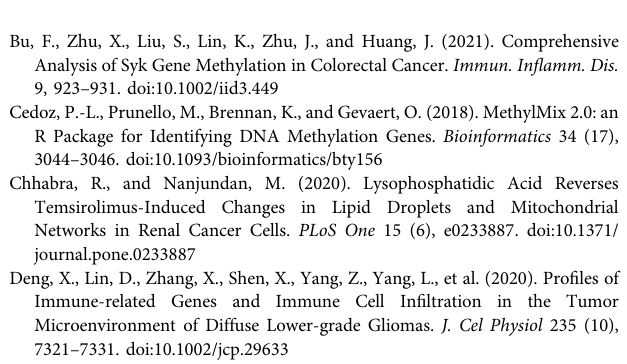
Supplementary Table 1 | Primer sequences involved in this study. Supplementary Table 2 | 270 MDGs in RCC samples and normal samples. Supplementary Table 3 | Correlation between the prognostic model and tumor- in fi ltrating immune